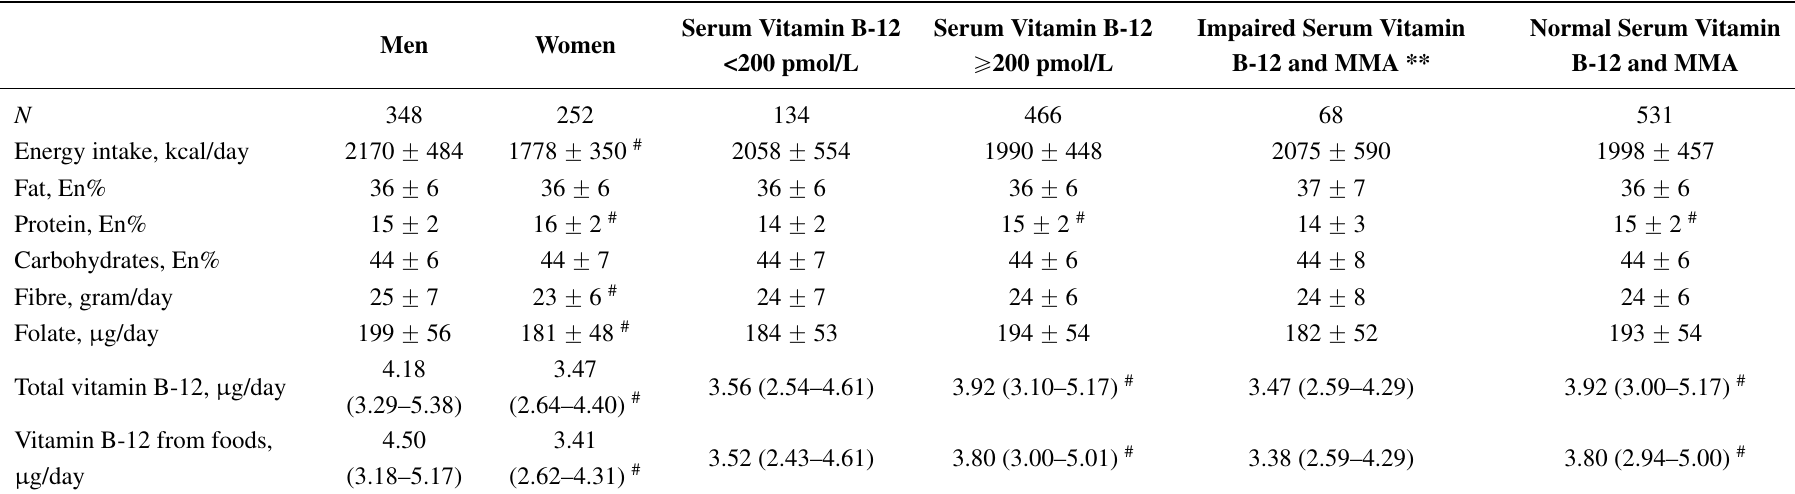
Table 2. Dietary intakes of the participants of the B-PROOF Study ( n = 600)